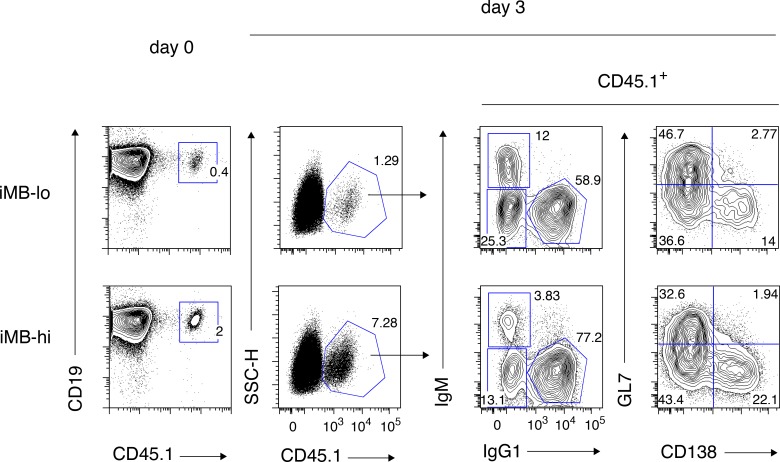
A gating strategy for IgM+ and IgG1+ cells used in Figure 4b.Spleen cells containing donor-derived (CD45.1+) iMB cells (left) were cultured as shown in Figure 4a,b. FCM profiles of the gated iMB cell-derived cells on day 3, with the gating strategy for the cell fractions used in Figure 4b, are shown (right). The analysis on day 2 in Figure 4a was gated in the same manner.